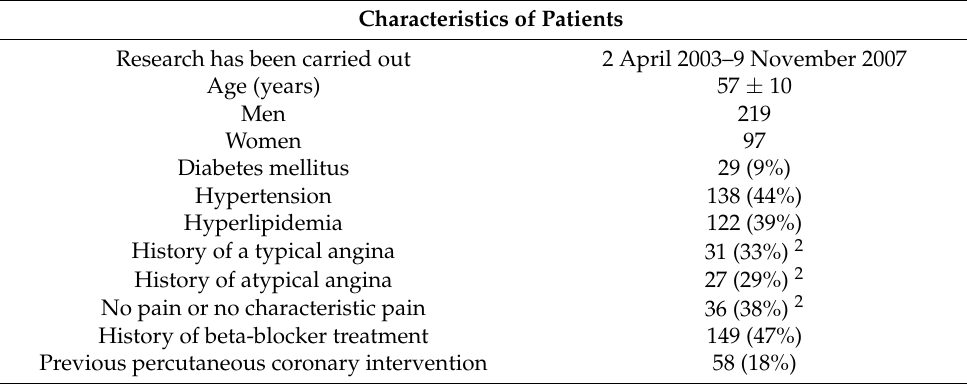
Table 1. Characteristics of 316 patients described in the database.